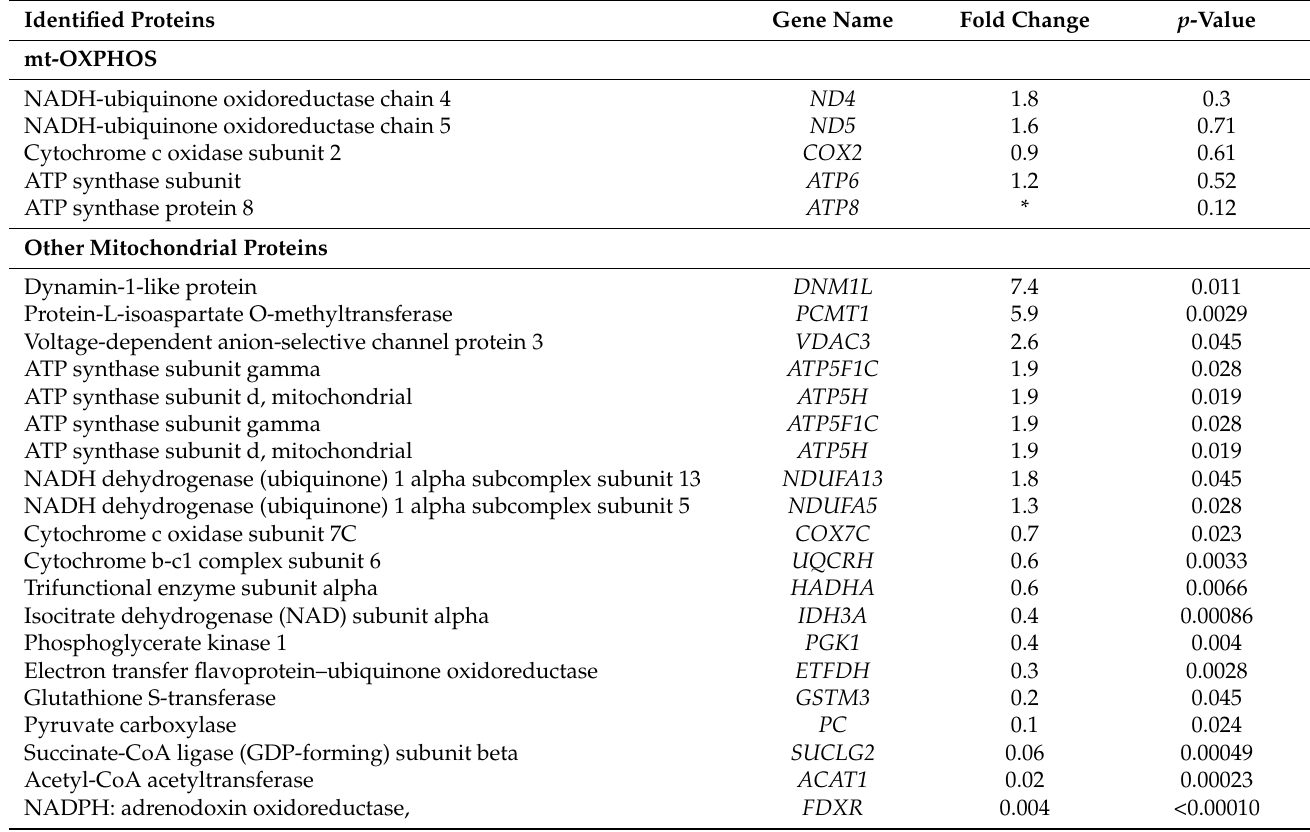
Table 3. Protein expressions’ change of mtOXPHOS and other relevant proteins in tumors compared to normal